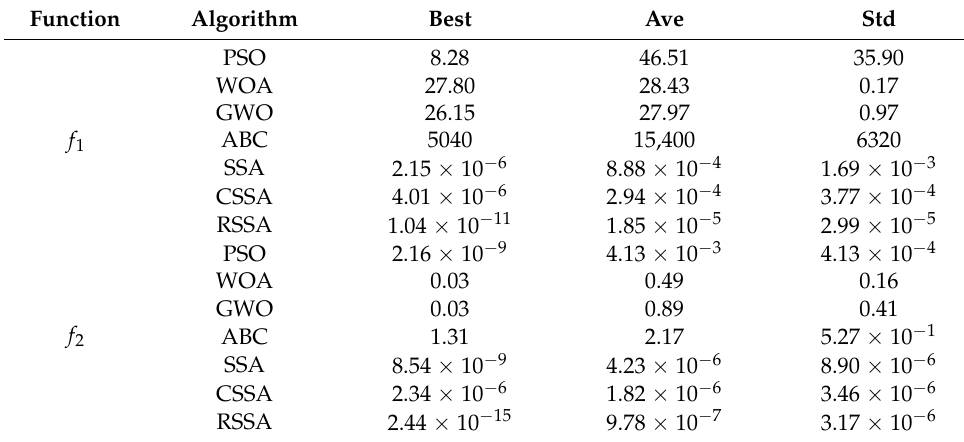
Table 4. Experimental results of test